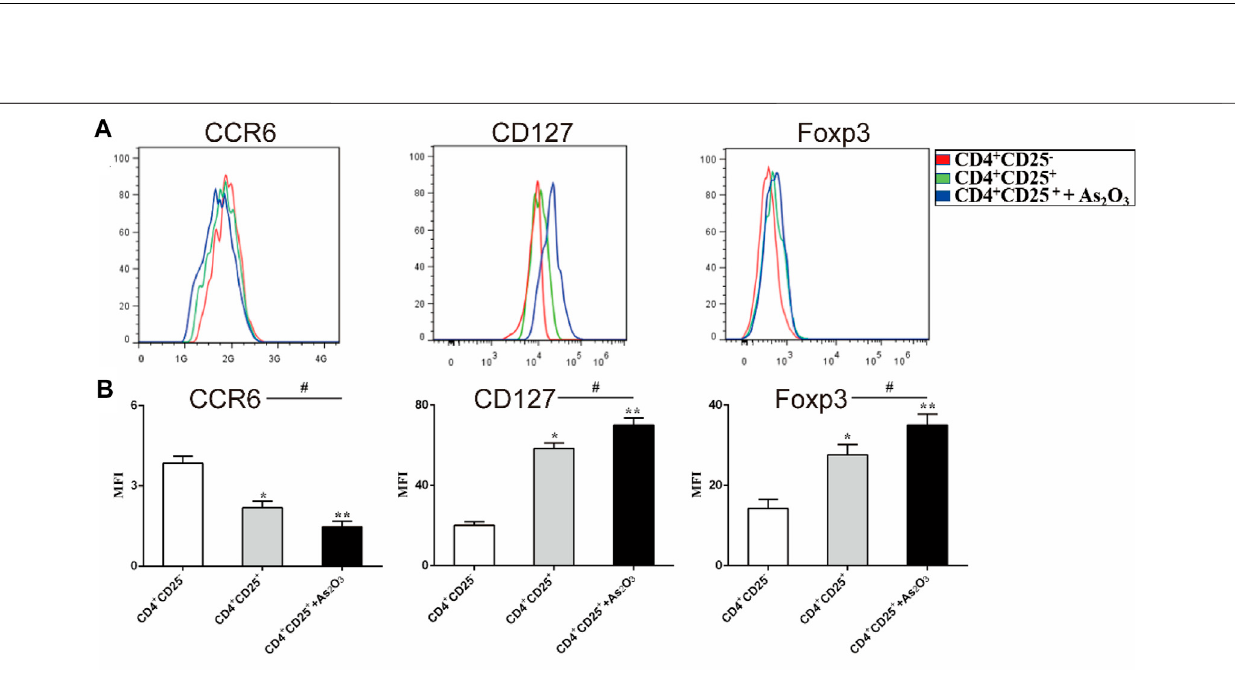
2.18 ± 0.24 vs 3.84 ± 0.27, p < 0.05), whereas the expression levels of the Treg-associated regulatory molecule CD127 and Foxp3 were signi fi cantly higher in CD4 + CD25 + Treg cells than in CD4 + CD25 −